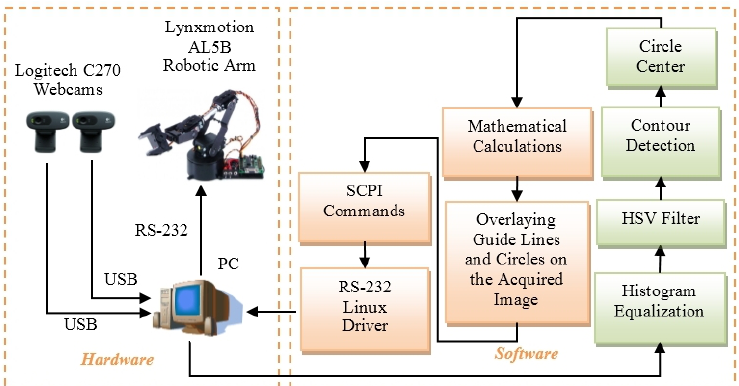
Figure 7. Block diagram for the robotic arm controlling experiment in the 3D space made in Linux implemented in C language and